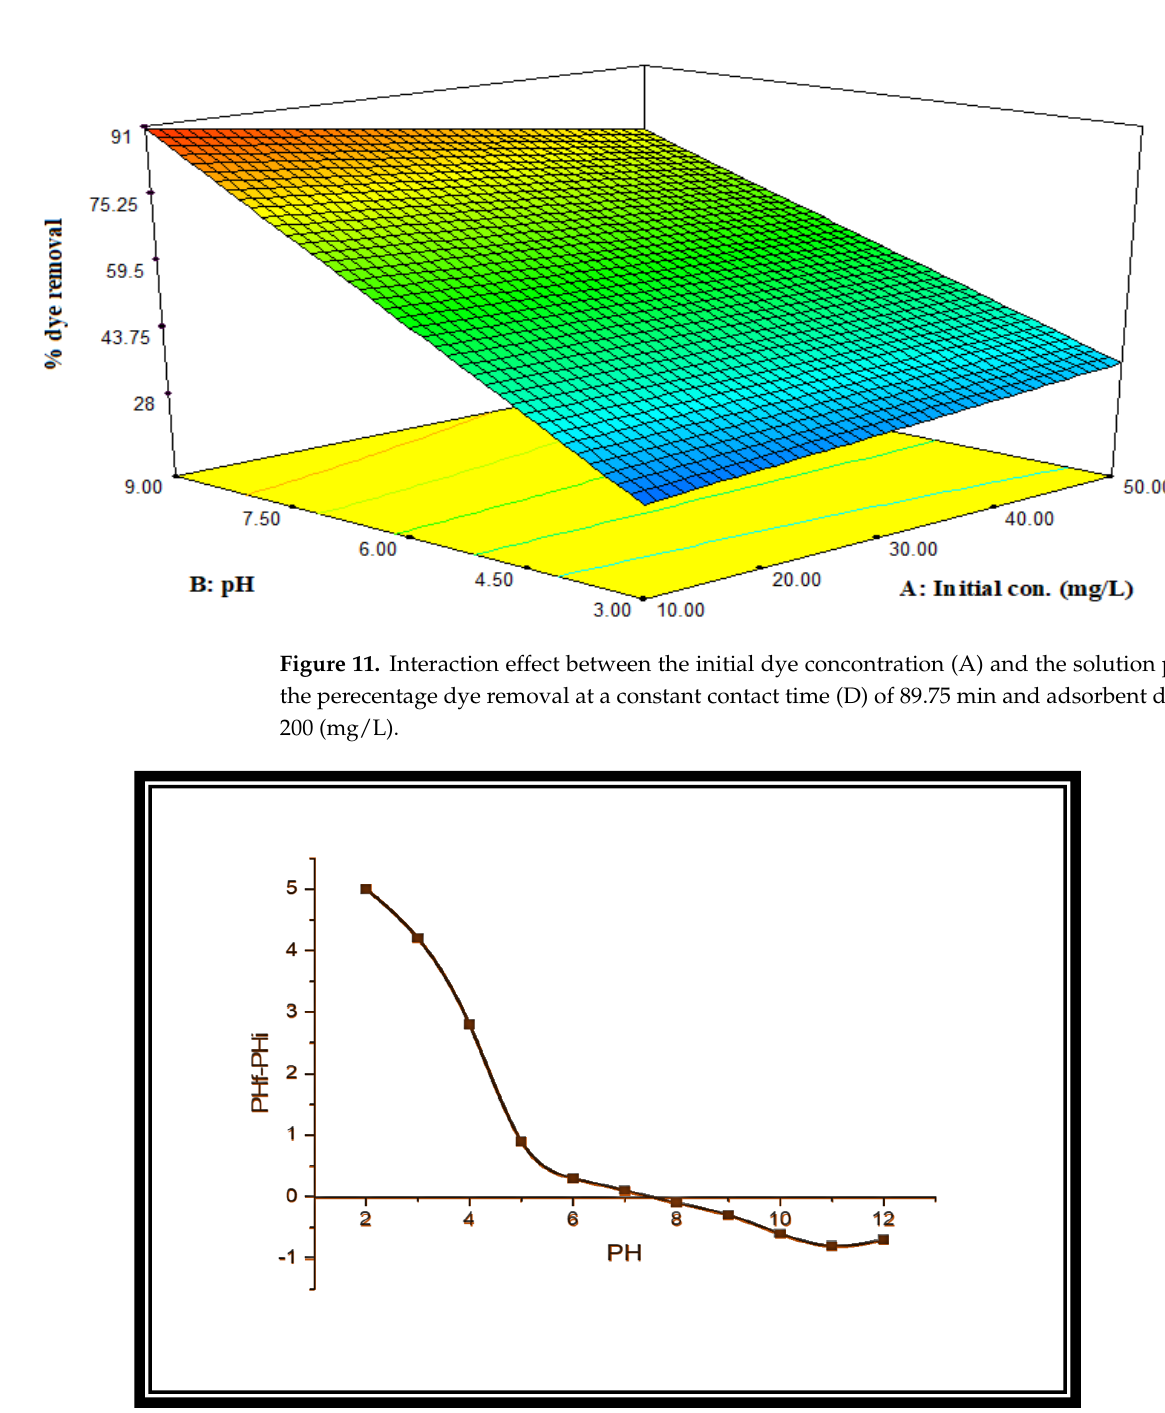
Figure 12. ( pHf-pHi) versus pH for Fe 3 O 4 NPs/CA.